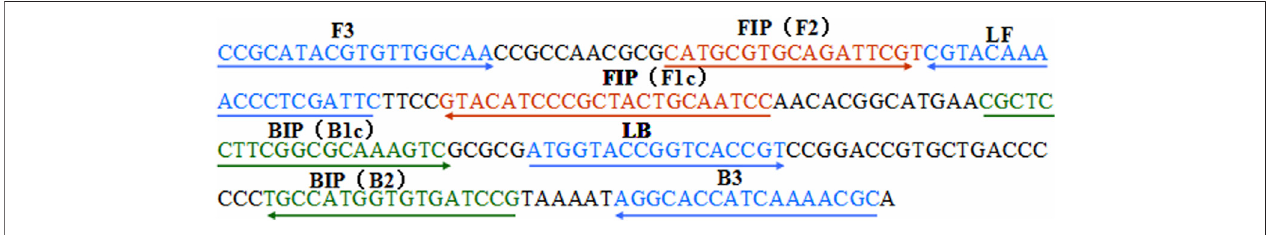
FIGURE1| Locationsoftheprimersequencesusedinthisstudyfortargetingthepertussistoxin(PT)promoterregionof Bordetellapertussi s. Right and leftarrows show the sense and complementary sequences, respectively. The colored text indicates the positions of the primers, including two outer primers (F3 and B3), two inner primers (FIP and BIP), and two loop primers (LF* and LB).